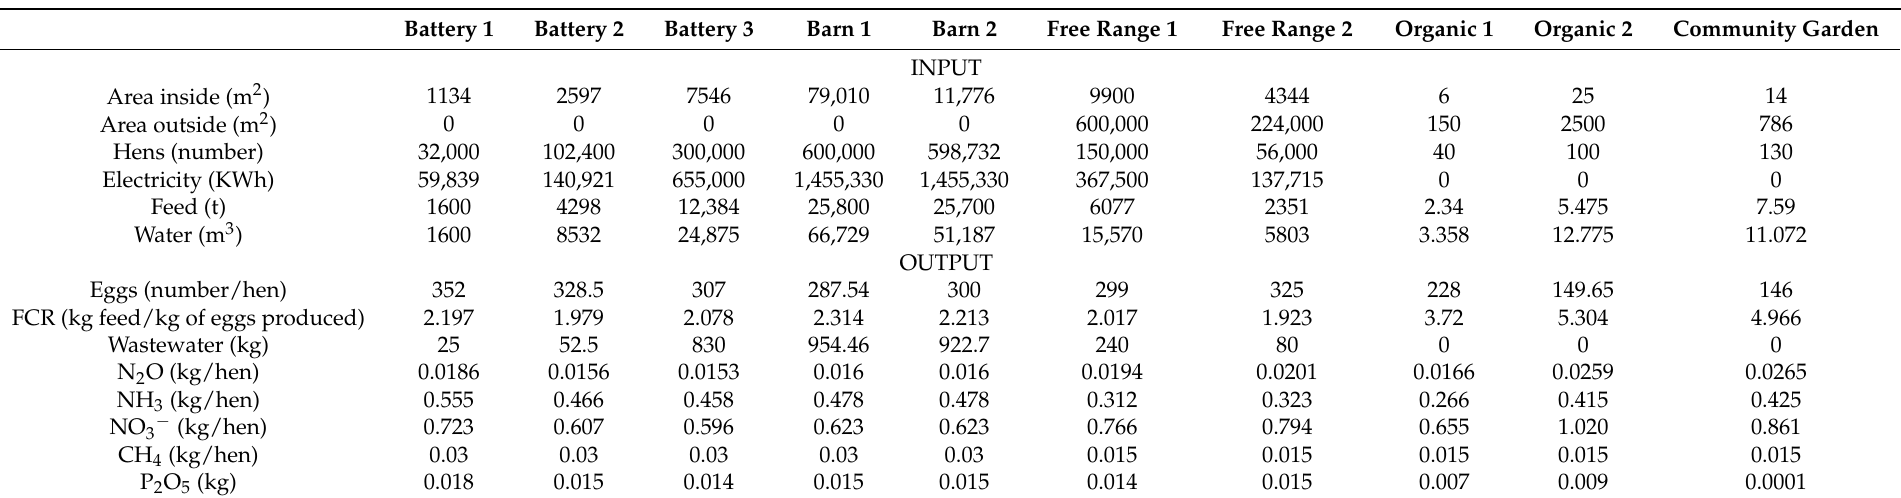
Table 2. Annual inventory of the